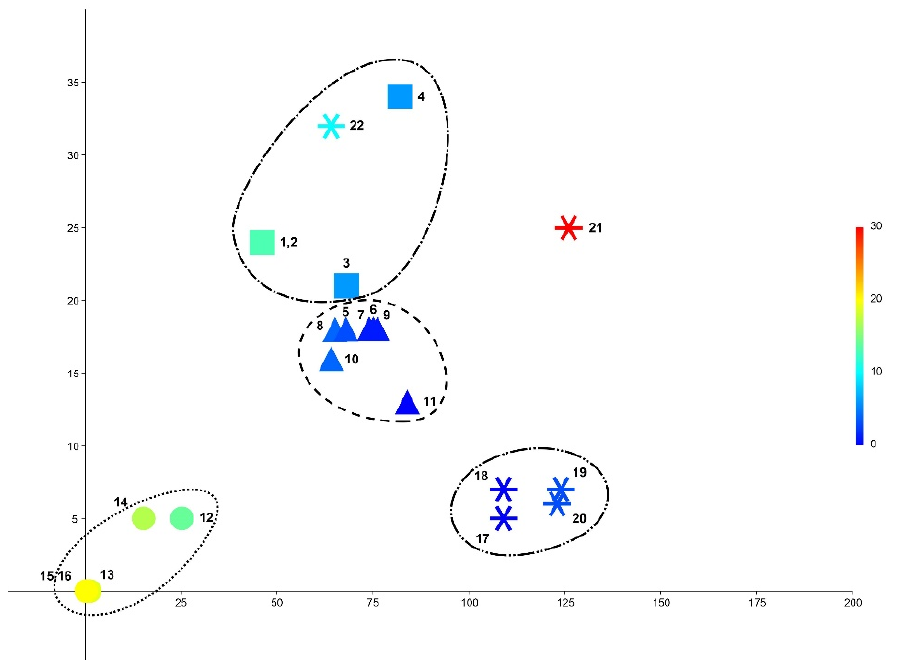
Figure 2. Comparison of the flora distribution in the DCA bubble chart (the third axis is the color gradient from deep blue to deep red). The taxonomical units revealed in the present account are encircled as follows: (1) dots— Tetralophozia sibirica , (2) dashes— T. pusilla , (3) dash-dotted line— T. filiformis s. str., (4) dash-two dots line—unknown climatic race. The specimens numbers are as in Table 3.